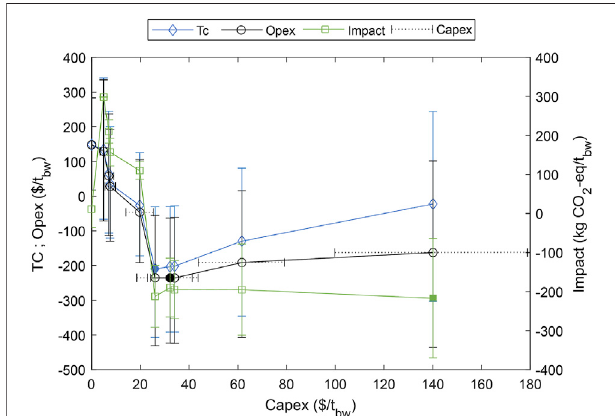
FIGURE7| Paretotrade-off.Verticallinesrepresentthe95%con fi dence interval (CI) in total cost (Tc), operating cost (Opex) and environmental impact (impact). Horizontal dashed lines represent the 95% CI on capital expenditures (Capex). Filled markers portray solutions with the average lowest values. Trend lines are for visual support only.